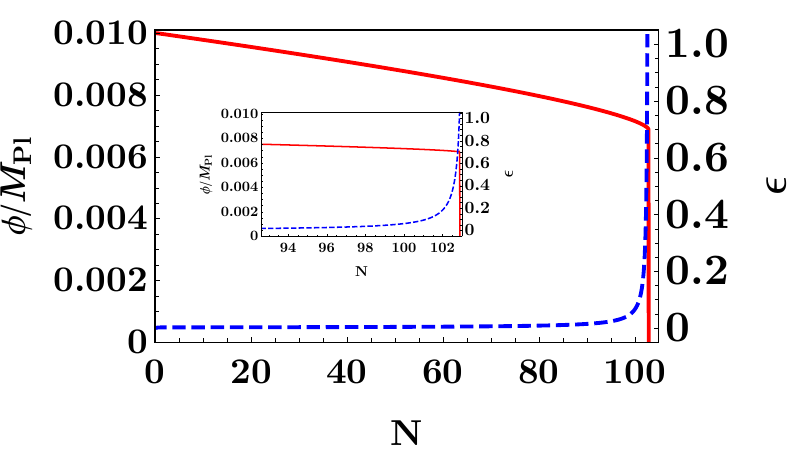
Figure 2 . Scalar field inflationary evolution with initial value ˜ φ = 0 . 01 M Pl and mass m = 500 Λ ? , producing N = 103 e-folds of inflation. Inset: Zooming in over the end of inflation. Notice that the slow-roll condition is valid until the very end, i.e., (cid:15) is approximately zero during the whole